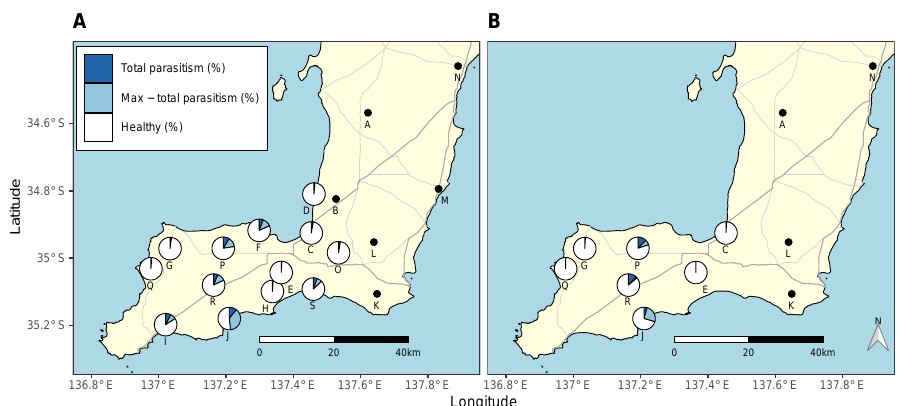
Figure 3. Geographic map of the Yorke Peninsula, South Australia, showing S. villeneuveana para- sitism rates on: ( A ) C. acuta at 19 sites; and ( B ) C. barbara at 11 sites. Pies display the total parasitism rate across all sampling dates (dark blue) and the maximum parasitism rate on any single sampling date (light blue and dark blue) at sites where the fly was present. Black dots represent sites where snails were collected but S. villeneuveana was not recovered.